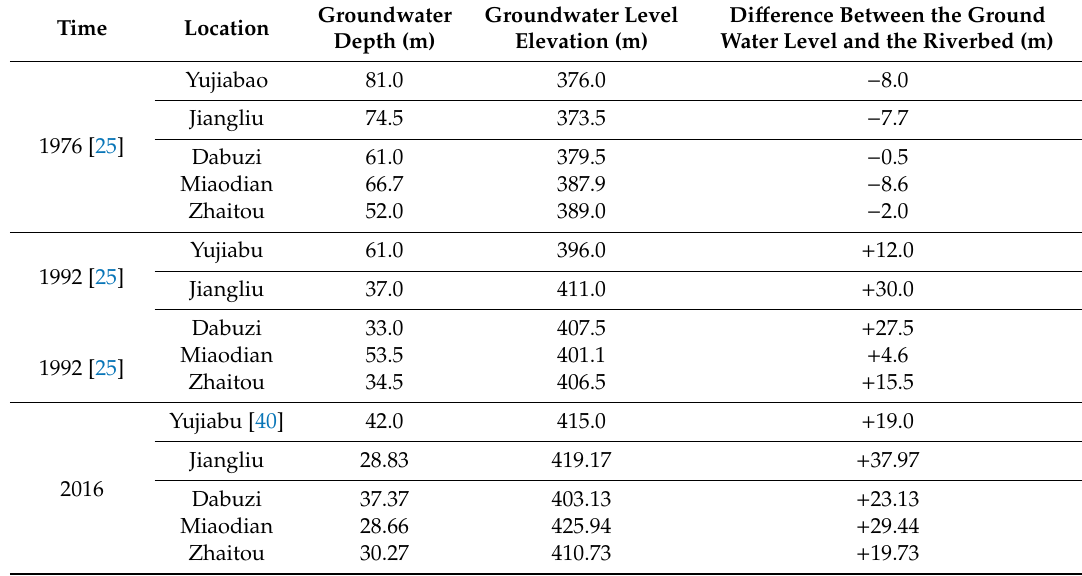
Table 3. Changes in groundwater levels at a representative point on the South Jingyang